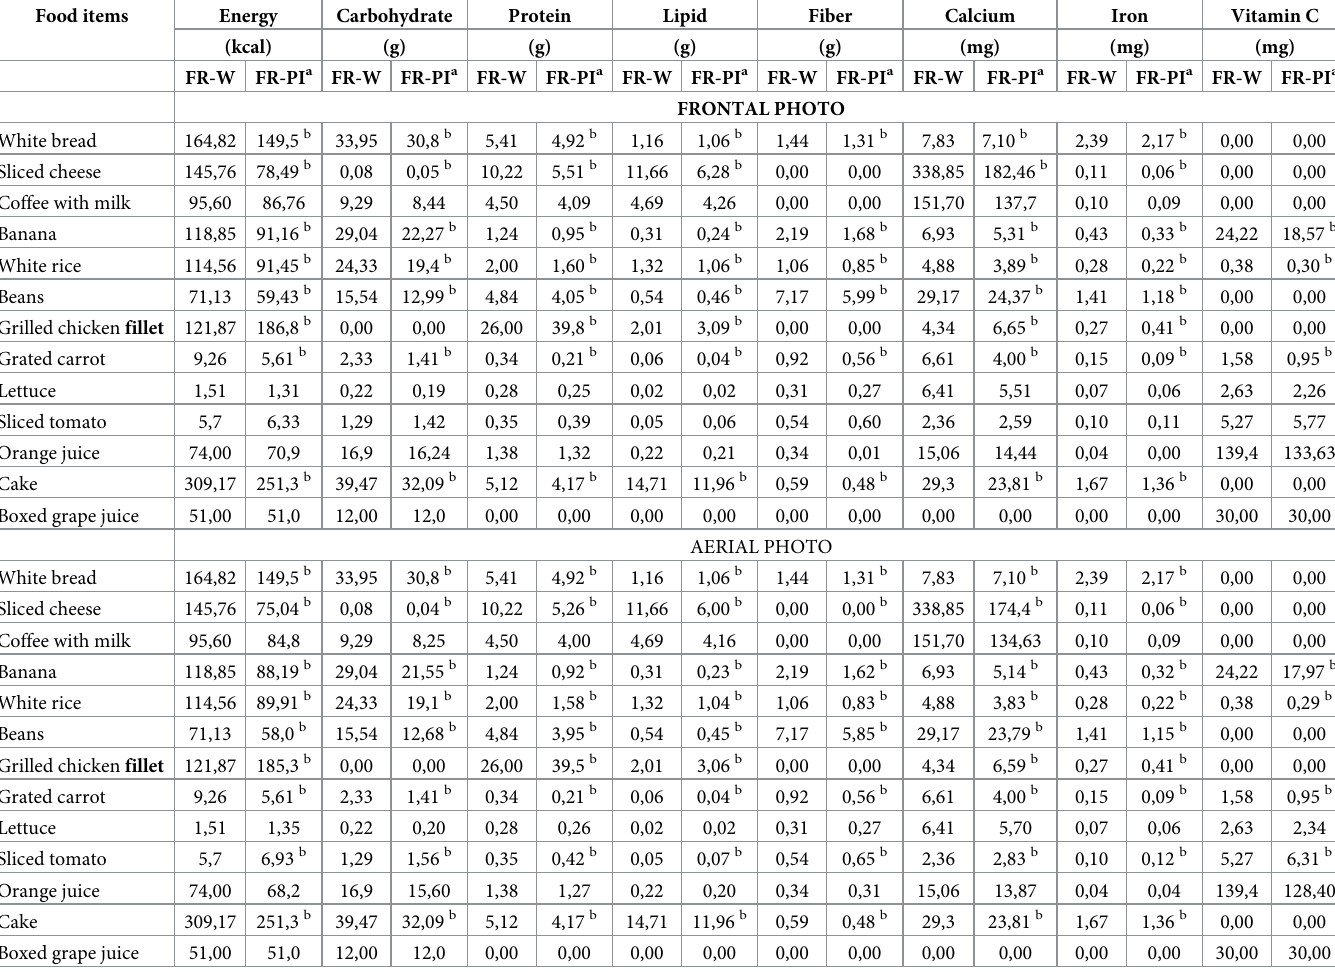
Table 3. Quantity of nutrients present in the meal, according to the weighed food record (FR-W) and the estimated food record based on photographic images (FR-PI) captured in frontal photos by the visually impaired participants. Natal, Rio Grande do Norte, Brazil -2019. Food